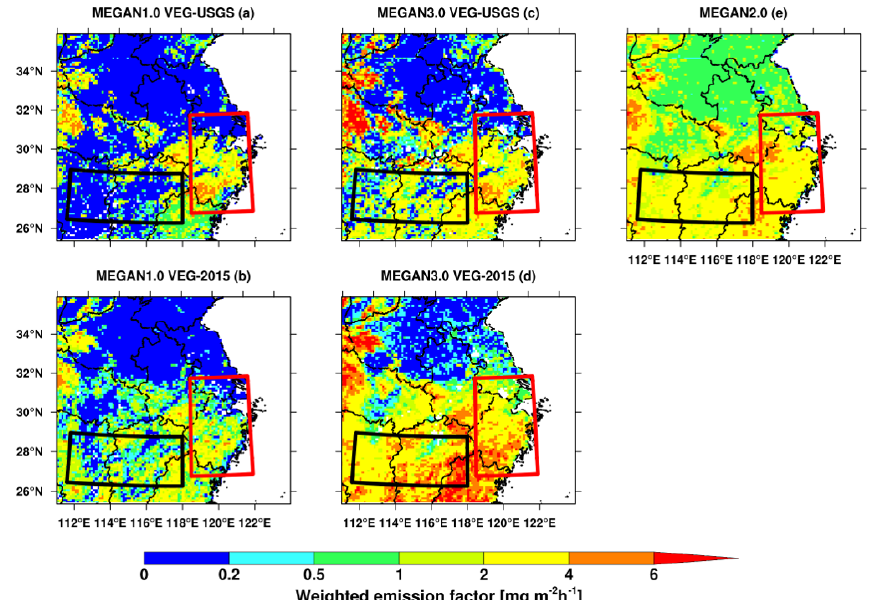
Figure 4. Spatial distribution of the weighted mean emission factors derived from VEG-USGS and VEG-2015 in MEGAN v1.0 (a, b) and MEGAN v3.0 (c, d) . Meanwhile, (e) shows the distribution of isoprene emission factors in the MEGAN v2.0 database. Please note the emission factors of isoprene are prescribed for MEGAN v2.0 in WRF-Chem and therefore are independent of vegetation